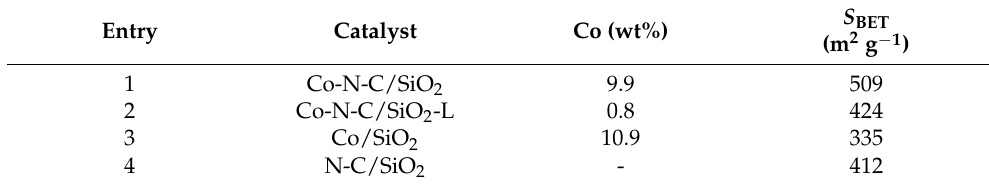
Figure 3. ( a ) HAADF-STEM and related ( b – f ) EDX-STEM Co, N, C, Si and O elemental mapping images of typical area of as-synthesized Co-N-C/SiO 2 catalyst. Table 1. Characterization data for the